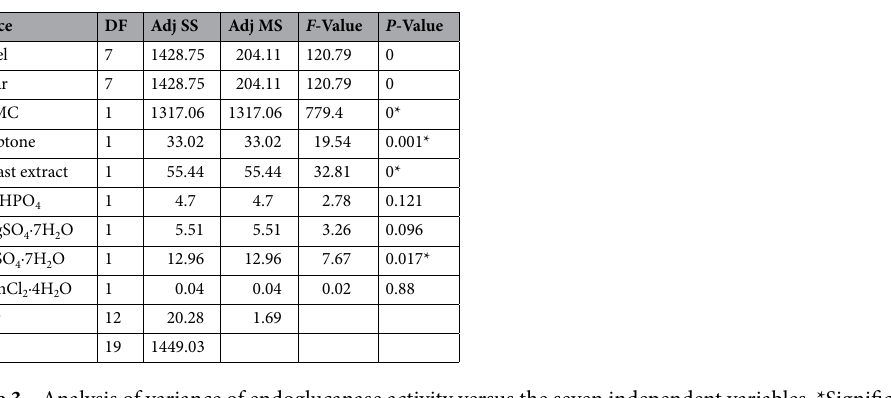
Table 3. Analysis of variance of endoglucanase activity versus the seven independent variables. *Significant values, df Degree of freedom, F Fishers’